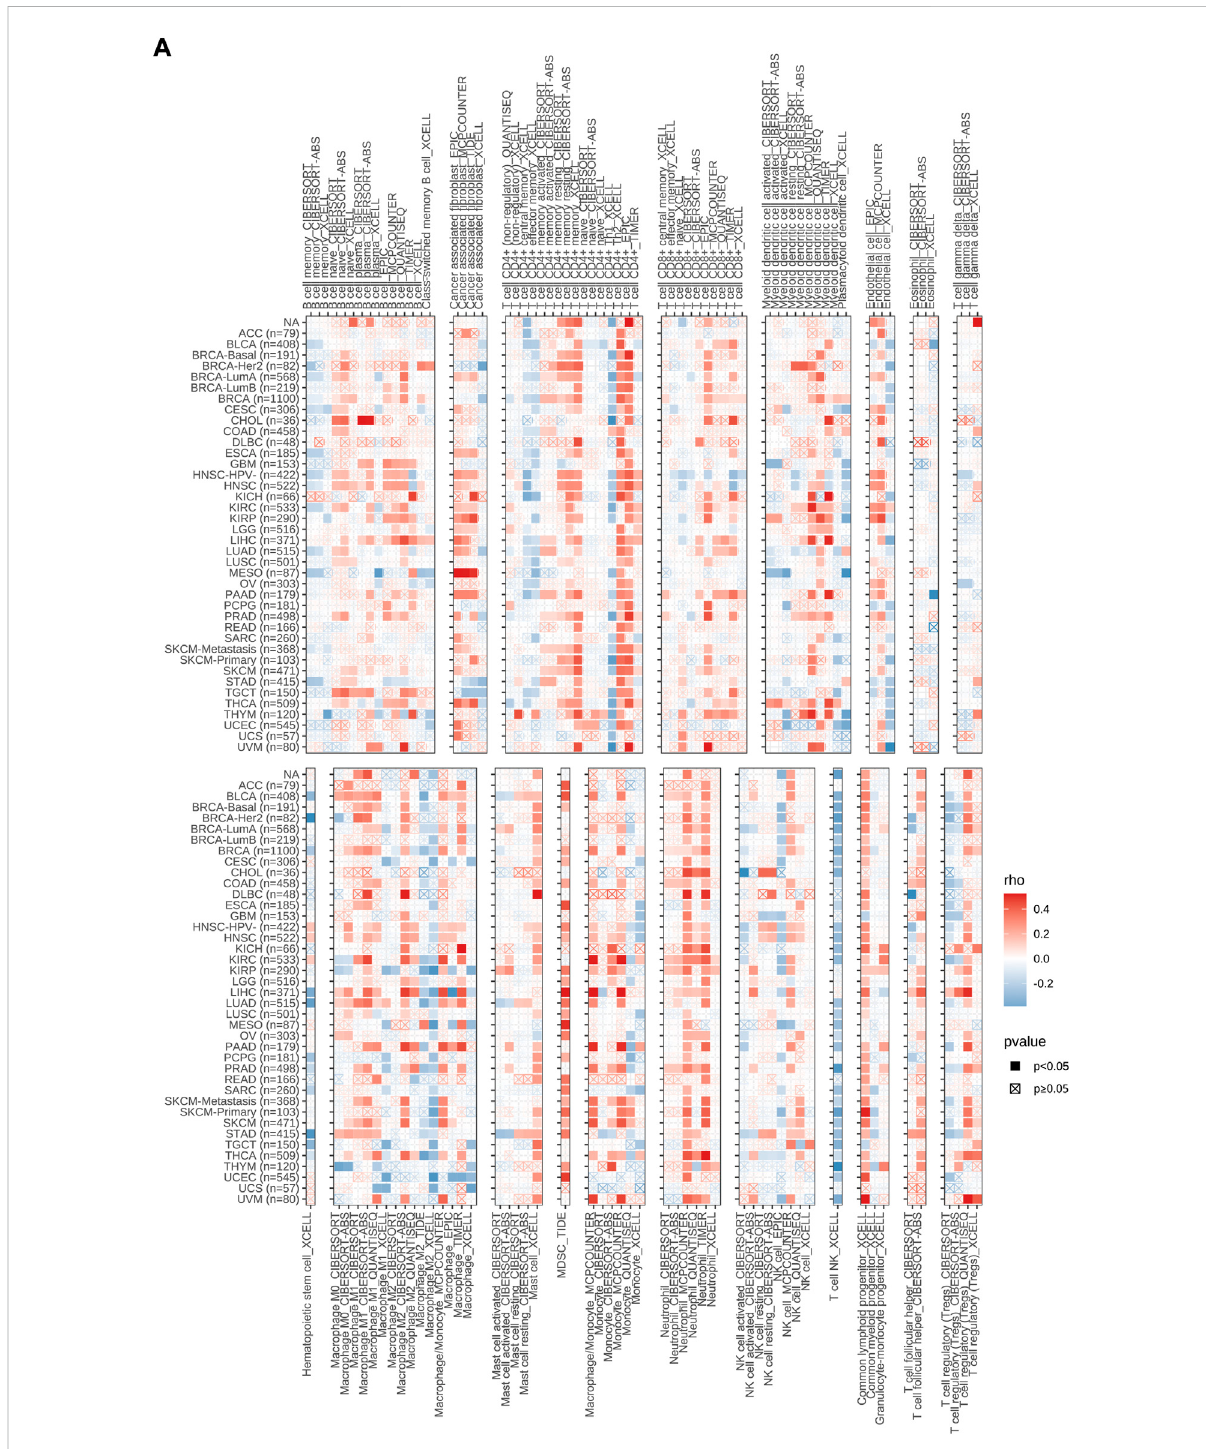
FIGURE 5 Associations of methyl methanesulfonate-sensitivity protein 22-like (MMS22L) expression with immune in fi ltration in pan-cancer. (A) The correlations of MMS22L mRNA expression and immune cell in fi ltration across human cancers according to the TIMER2.0